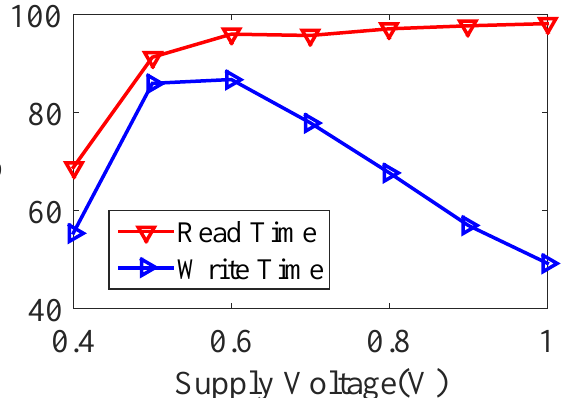
Figure 10. % Improvement in read and write performance in proposed RSAWA12 compared with the state-of-the-art design